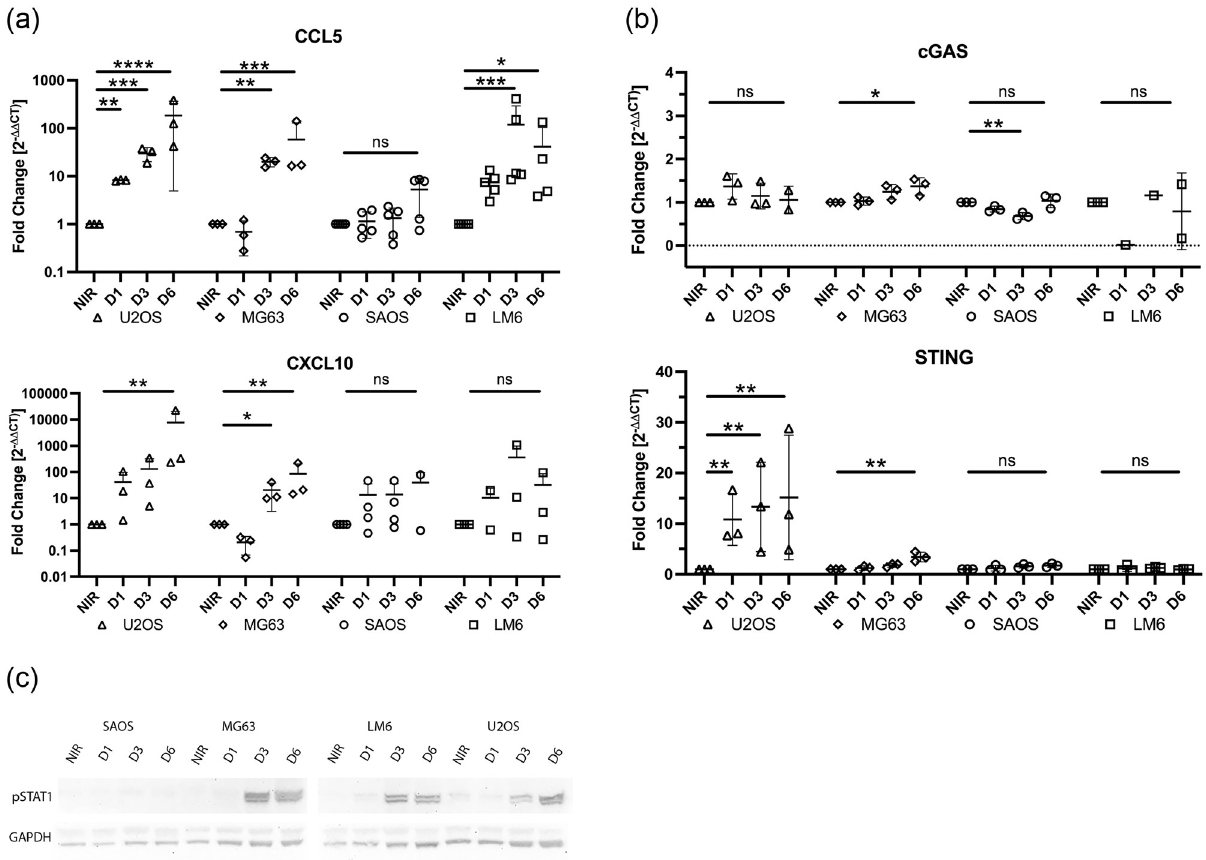
Fig 3. Expression of chemokines induced by 5Gy ionizing radiation in hOSA cells. A) CCL5 and CXCL10 mRNA expression depicted as fold change (2 - ΔΔ Ct ) at 1 day (D1), 3 days (D3), and 6 days (D6) post radiation exposure, compared to non-irradiated cells (NIR). The y-axis is represented on a log 10 scale. RT-qPCR was performed in duplicate. N = 3–5. B) cGAS and STING mRNA expression depicted as fold change (2 - ΔΔ Ct ) at various timepoints post radiation exposure, compared to NIR. RT-qPCR was performed in duplicate. N = 3. C) Phosphorylated STAT (pSTAT) protein expression in hOSA cell lines at various timepoints following radiation treatment compared to NIR control cells performed by Western blot. A representative image is shown, depicting pSTAT expression (~85–90 kDa) and the loading control, GAPDH (~35kDa). Three independent replicates were performed. Individual data points are plotted, mean and SD are shown. ns = not statistically significant; * p < 0.05; ** p < 0.01; *** p < 0.001; **** p < 0.0001.